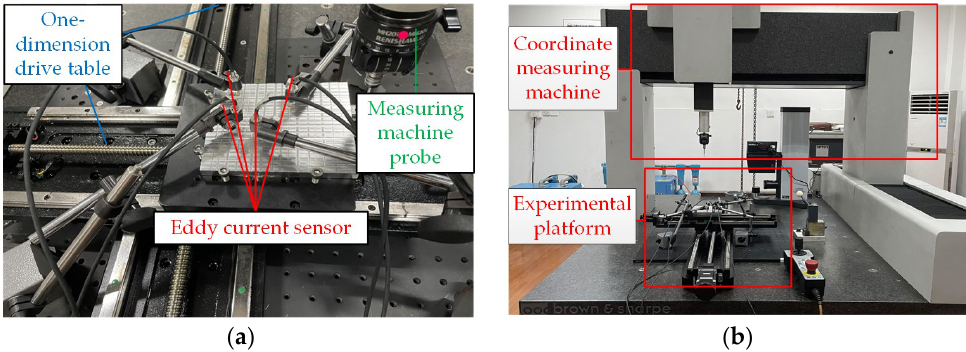
Figure 8. Experimental installation, ( a ) Overall experimental environment, ( b ) Details of the experimental device.